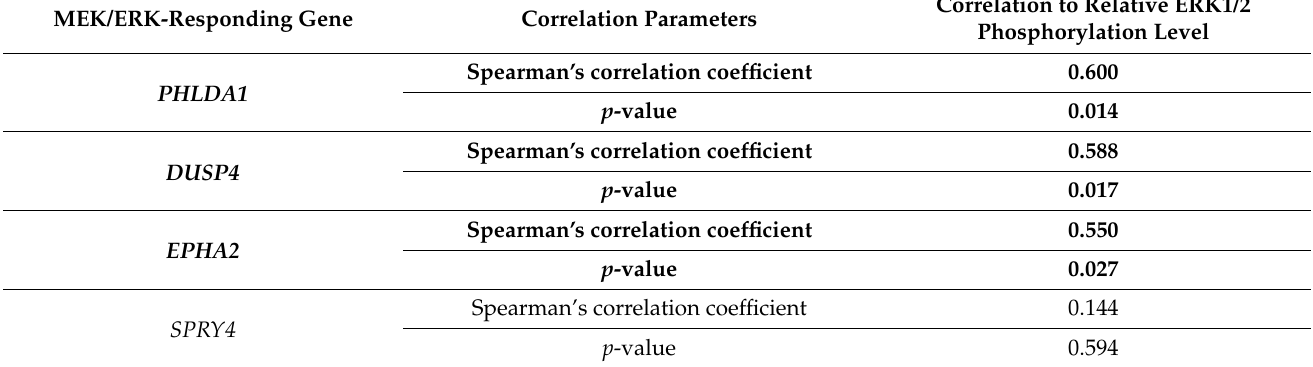
Table 2. Associations between expression levels of the most promising MEK/ERK responders and relative ERK phosphorylation levels in untreated ovarian cancer cell lines. Positive correlation coefficients imply that two parameters of interest display conforming trends (“both high” or “both low”) in the same samples, ranging from “0” (extremely weak association) to “1” (extremely strong association). Values in “0.5–0.6” interval imply a moderate-to-strong association between parameters. p -value reflects the statistical significance of correlation coefficient being correctly calculated. Genes emphasized with bold text display statistically significant associations with ERK1/2